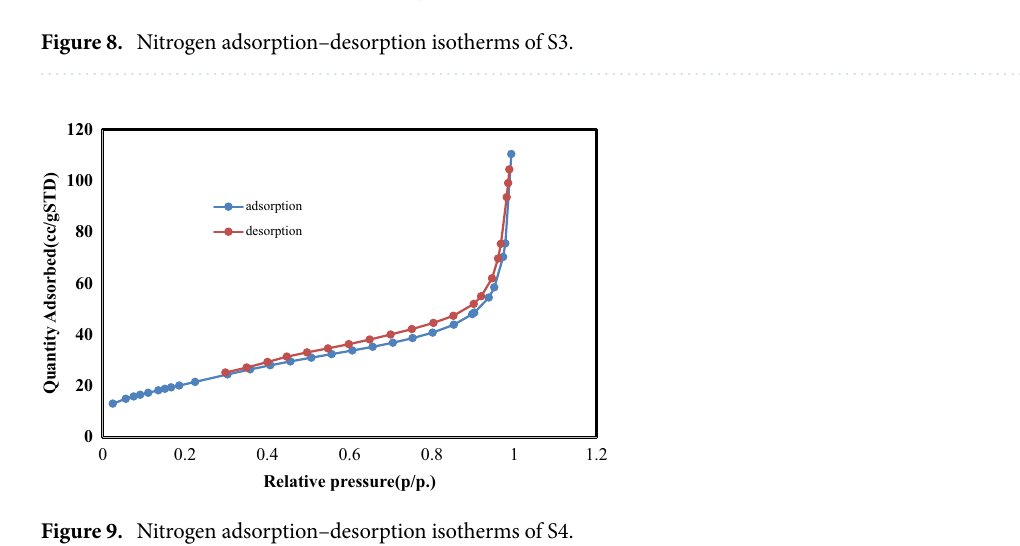
Figure 9. Nitrogen adsorption–desorption isotherms of